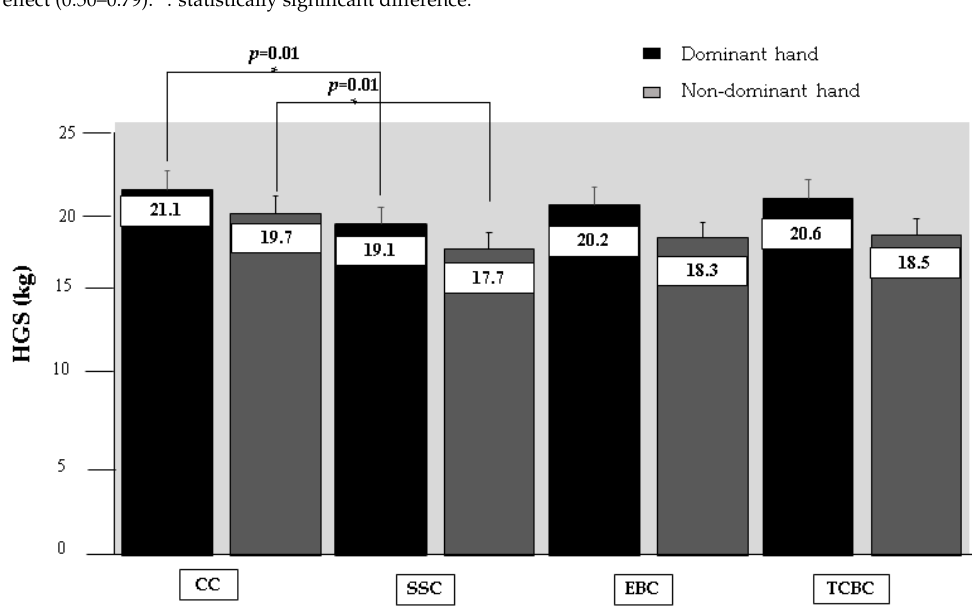
Table 3. Differences between intervention conditions on handgrip strength in physically inactive older females according to their baseline nutritional status. Intervention Conditions